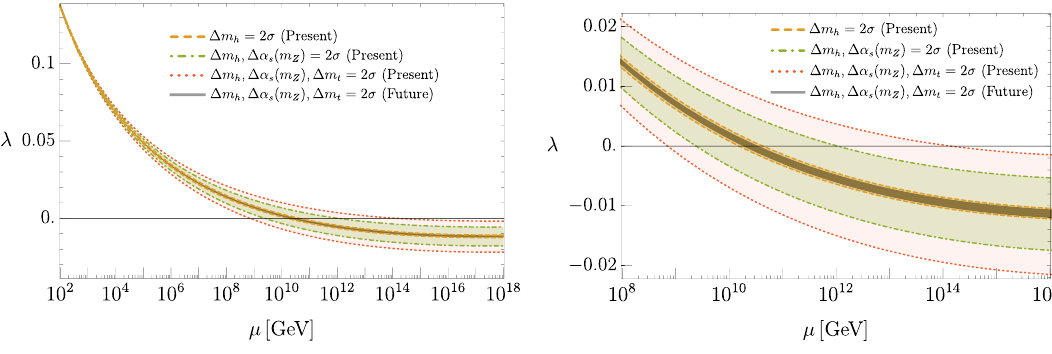
Figure 1 . Running of the SM quartic coupling with current and future uncertainties in m t , α s ( m Z ) , and m h . Their central values are m t = 172 . 76 GeV , α s ( m Z ) = 0 . 1179 , and m h = 125 . 10 GeV